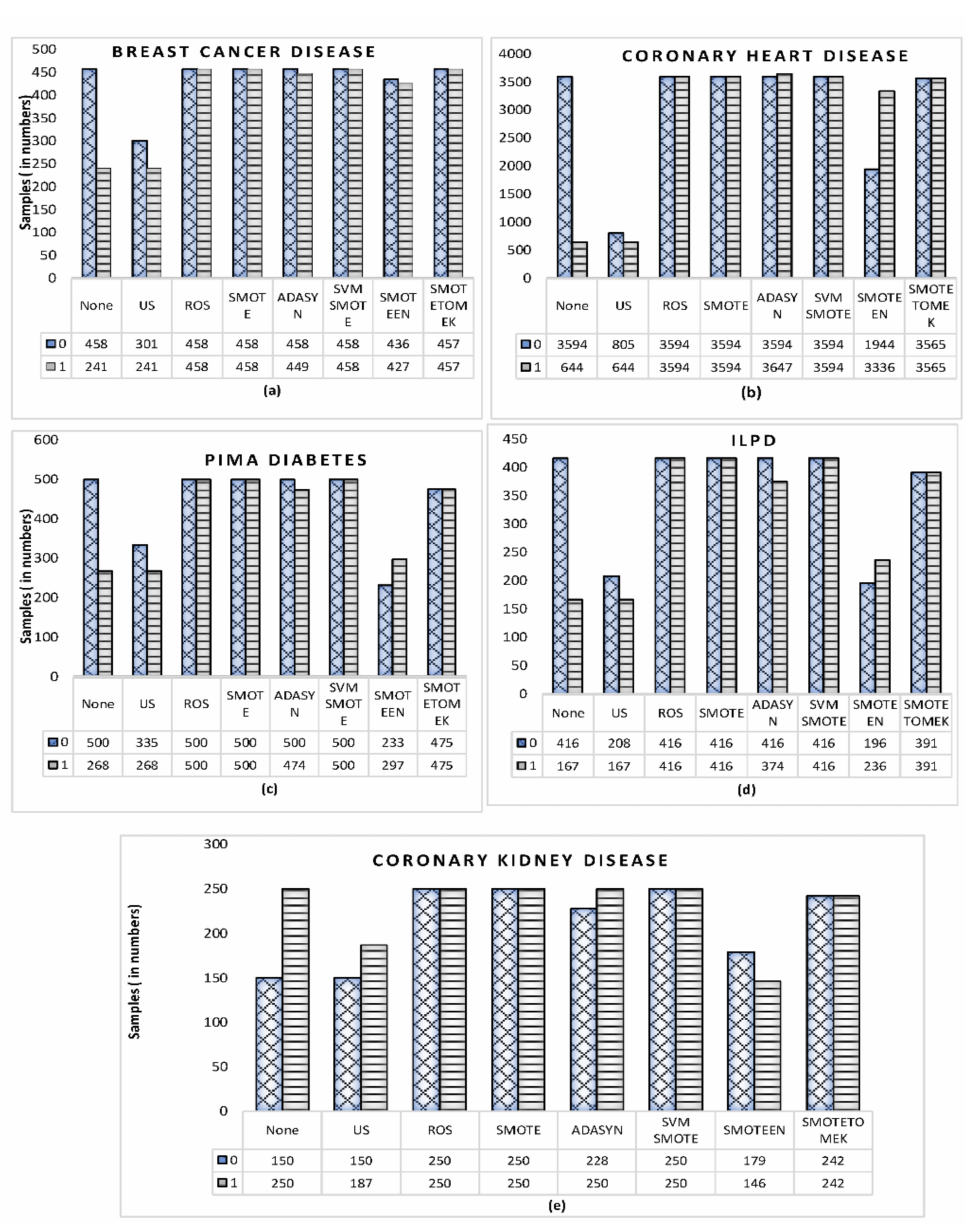
Figure 5. Class label counts before and after applying the various data-balancing techniques for datasets: ( a ) Breast cancer disease, ( b ) Coronary heart disease, ( c ) Pima diabetes dataset, ( d ) Indian liver patient disease, ( e ) Coronary kidney